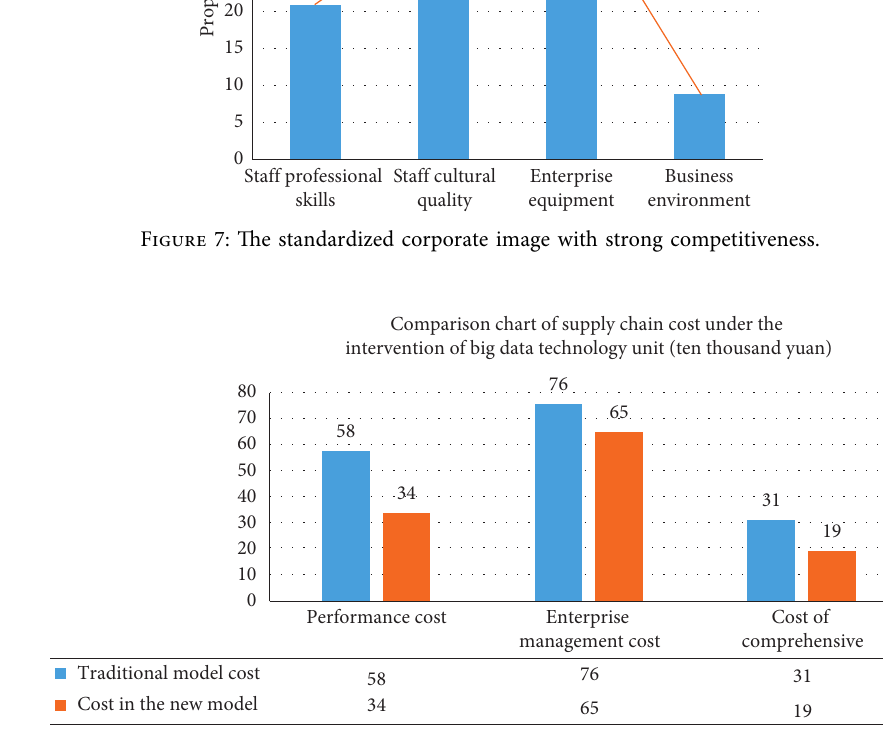
Figure 8: Comparison of SCCs under the intervention of big data. Table 4: Running time when Co, GA, and PSO are applied to the